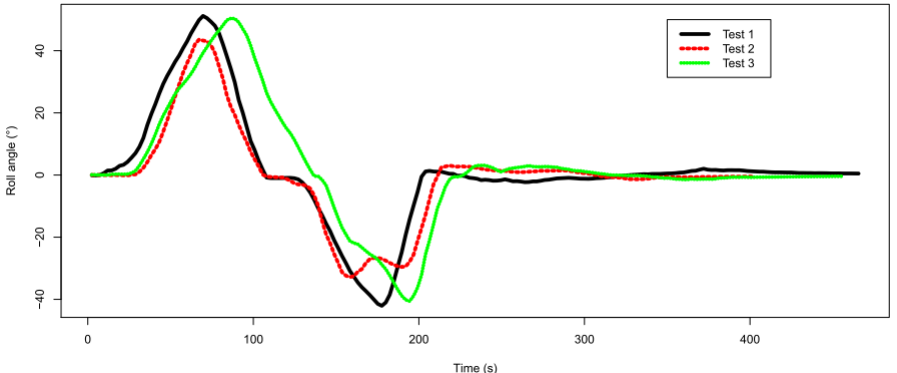
Figure 9. Roll angle profiles resulting from the performed tests.